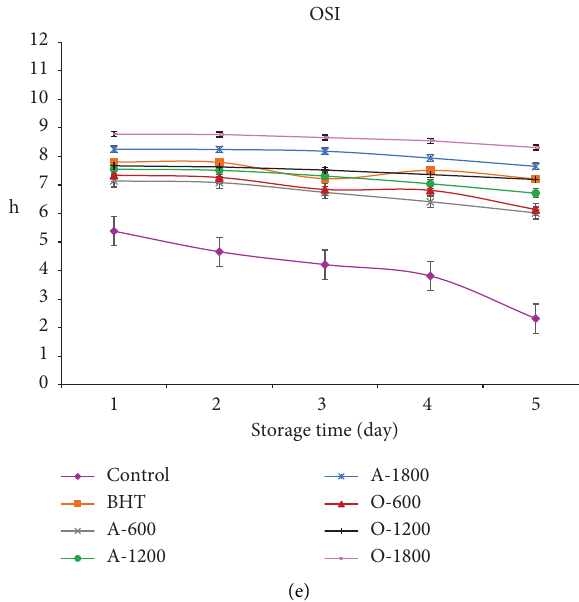
Figure 1: Te oxidative stability of chia seed oil during 5 days. O-600, O-1200, and O-1800: the treated oils with 600, 1200, and 1800ppm oregano extract, respectively. A-600, A-1200, and A-1800: the treated oils with 600, 1200, and 1800ppm Achilea extract,